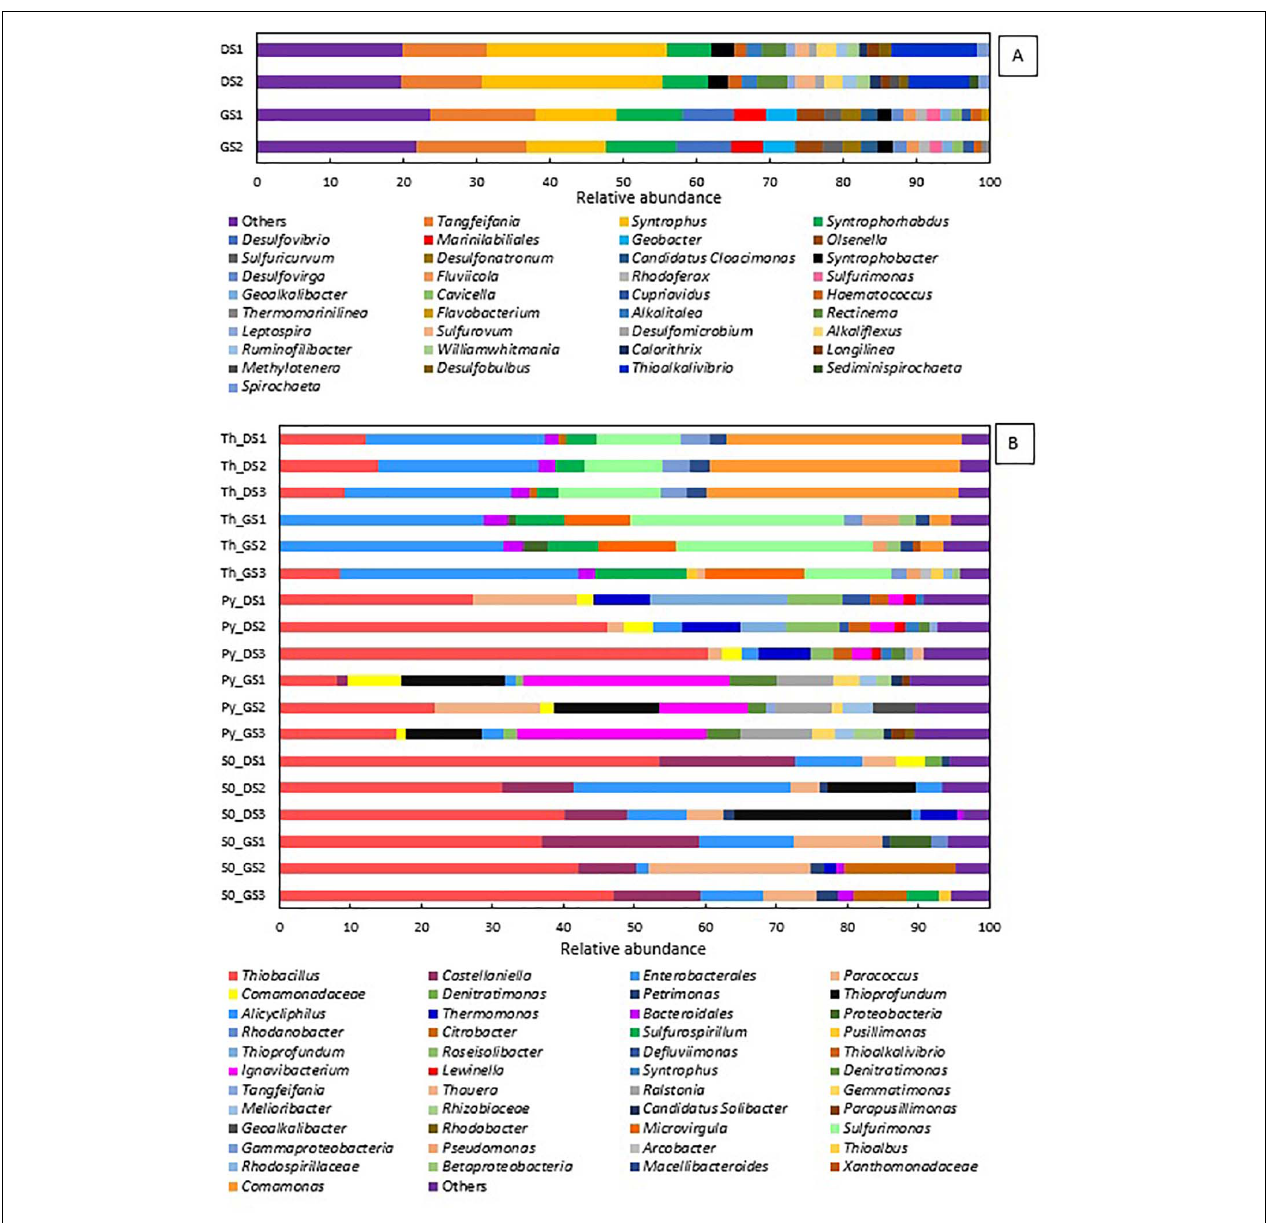
Figure 3 | Relative abundance at genus level present in the (A) inocula—in duplicate—and (B) in the last transfer of ThEnr, PyEnr, and S 0 Enr—in